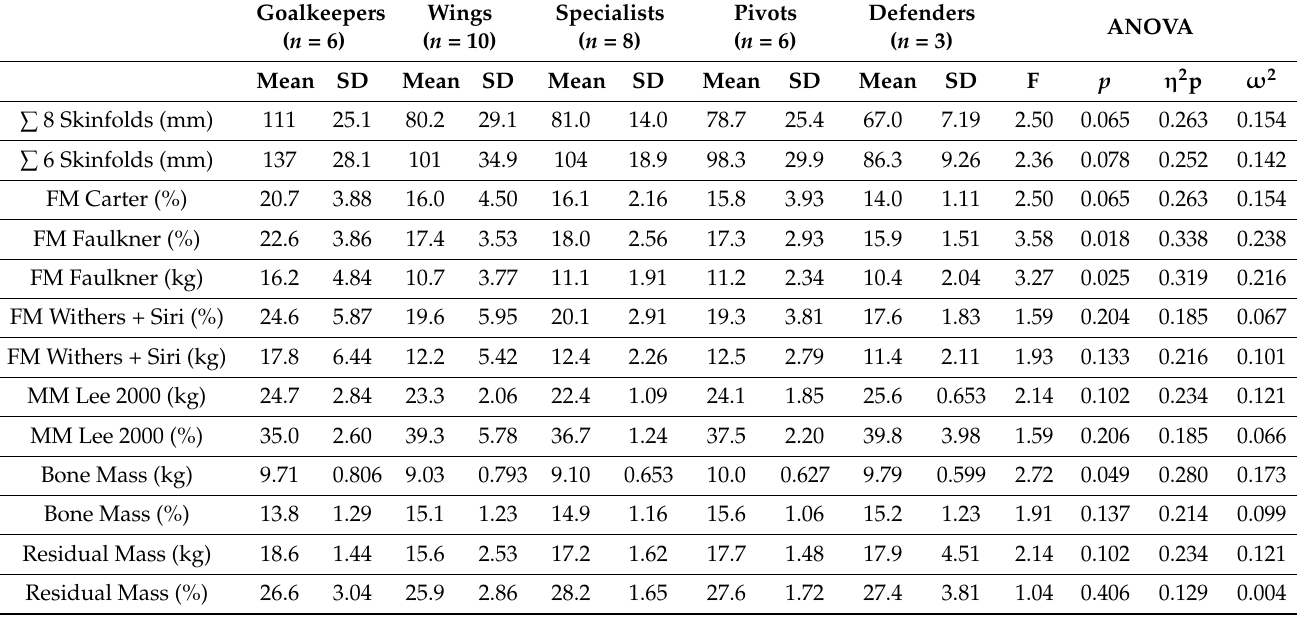
Table 5. Skinfolds and body composition according to playing position.